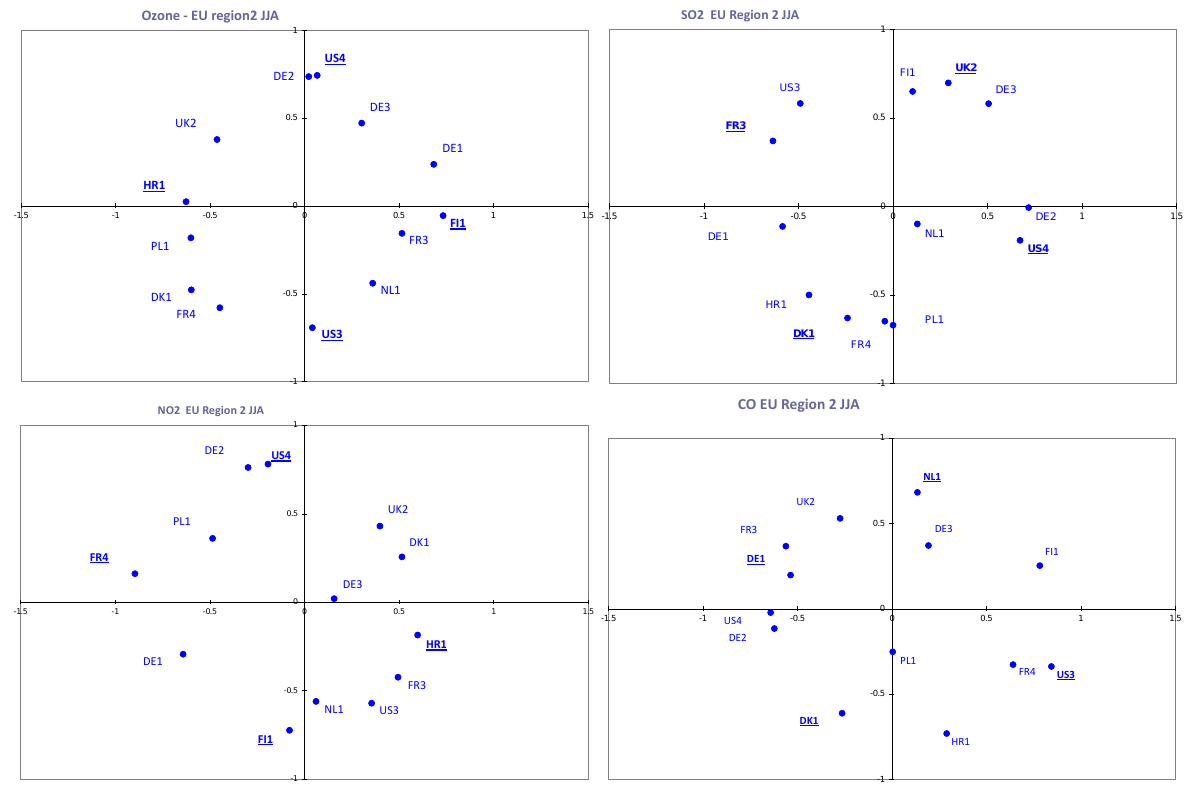
Fig. 7. 2-D MDS of corr( d i , d j ) for EU region 2. Models underlined are those selected to generate the reduced ensemble.